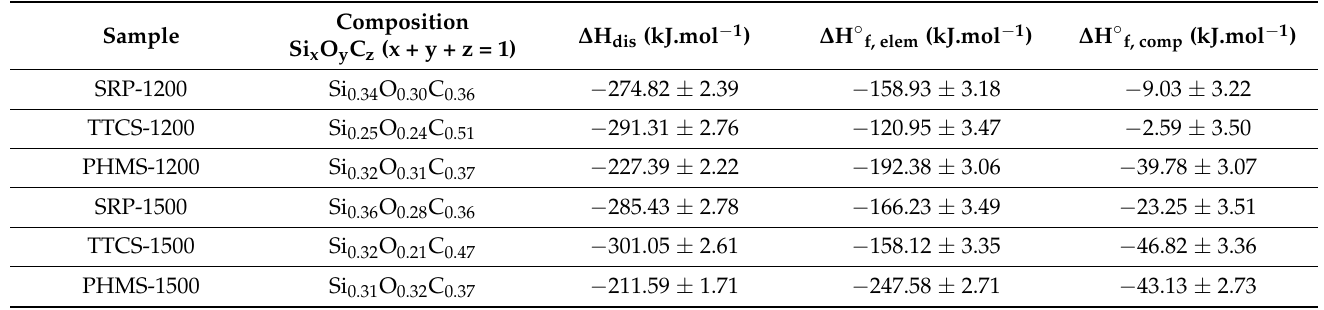
Table 6. Summary of thermodynamic analysis using Si-corrected (ignoring H) compositions from combustion analysis, plus C and O content as average of values from XPS and combustion technique.